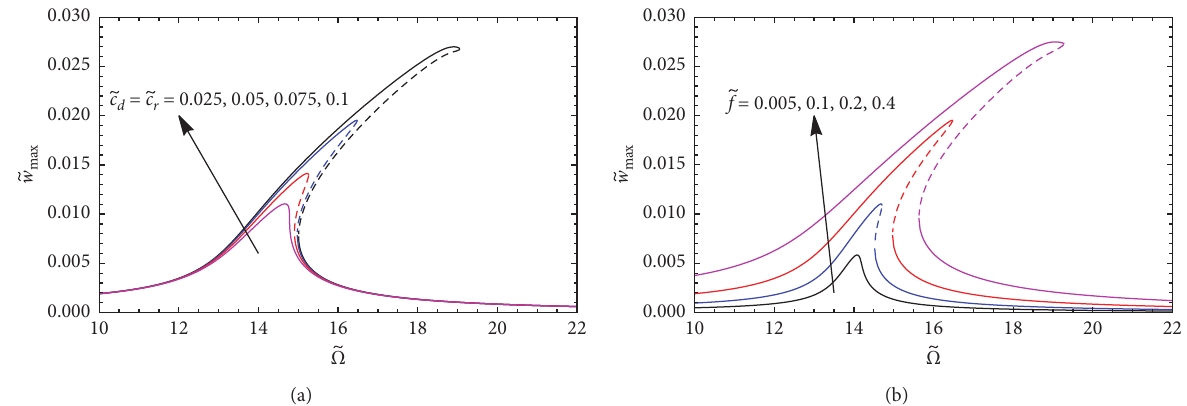
Figure 10: The effect of damping coefficients and magnitude of the excitation f on the frequency-response curves of transverse vibration of SS BDFG porous beam with m x � m z � 1, α and varying 􏽥 f .